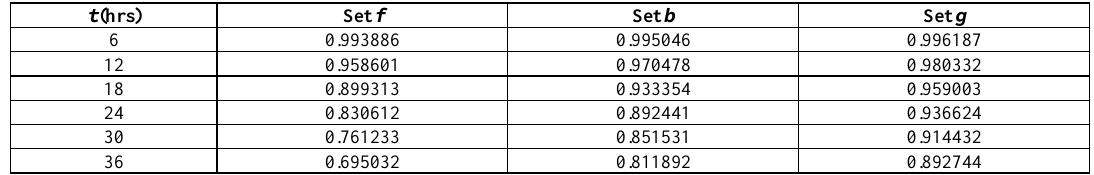
Table 4. The Bitcoin dependability under sets f, b, and g